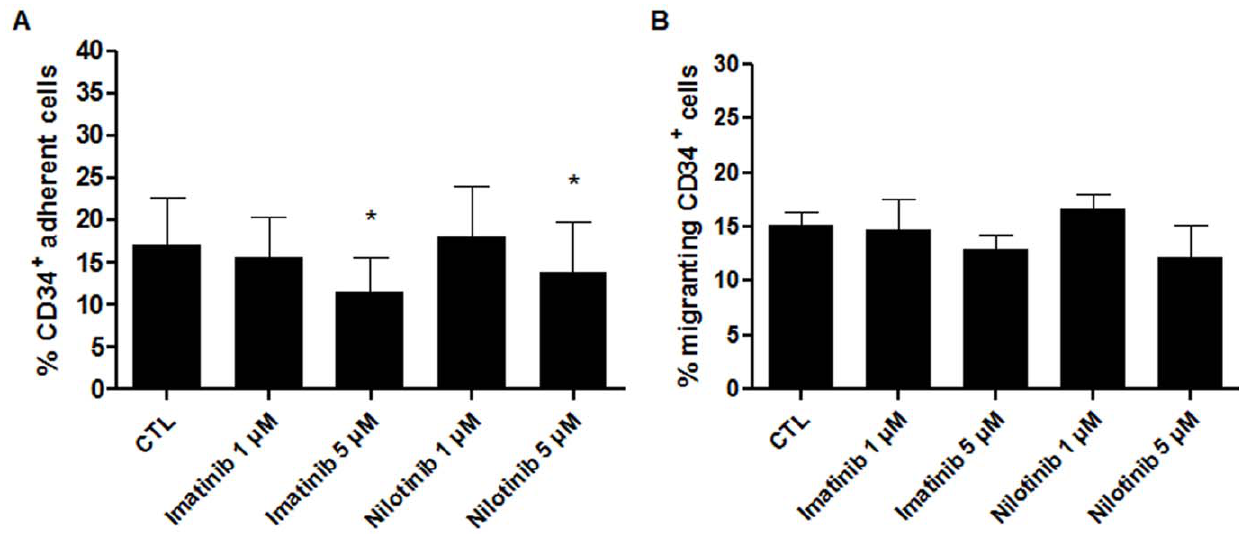
Figure 6. Influence of TKIs on adhesion and migration of human cord blood CD34 + cells. ( A ) : Adhesion of CD34 + cells to retronectin was significantly reduced in presence of the highest doses of TKIs. Results are expressed as the percentage of adherent cells 6 SD. n=10, *p , 0.05 versus CTL, Student’s paired t tests. ( B ) : Migration of human HSCs toward a SDF-1 a gradient was not modified by a 48 hour pre-culture period in the presence of TKIs. Results are expressed as the percentage of migrating cells 6 SD. n=4, Student’s paired t tests. CTL: control condition without TKIs.